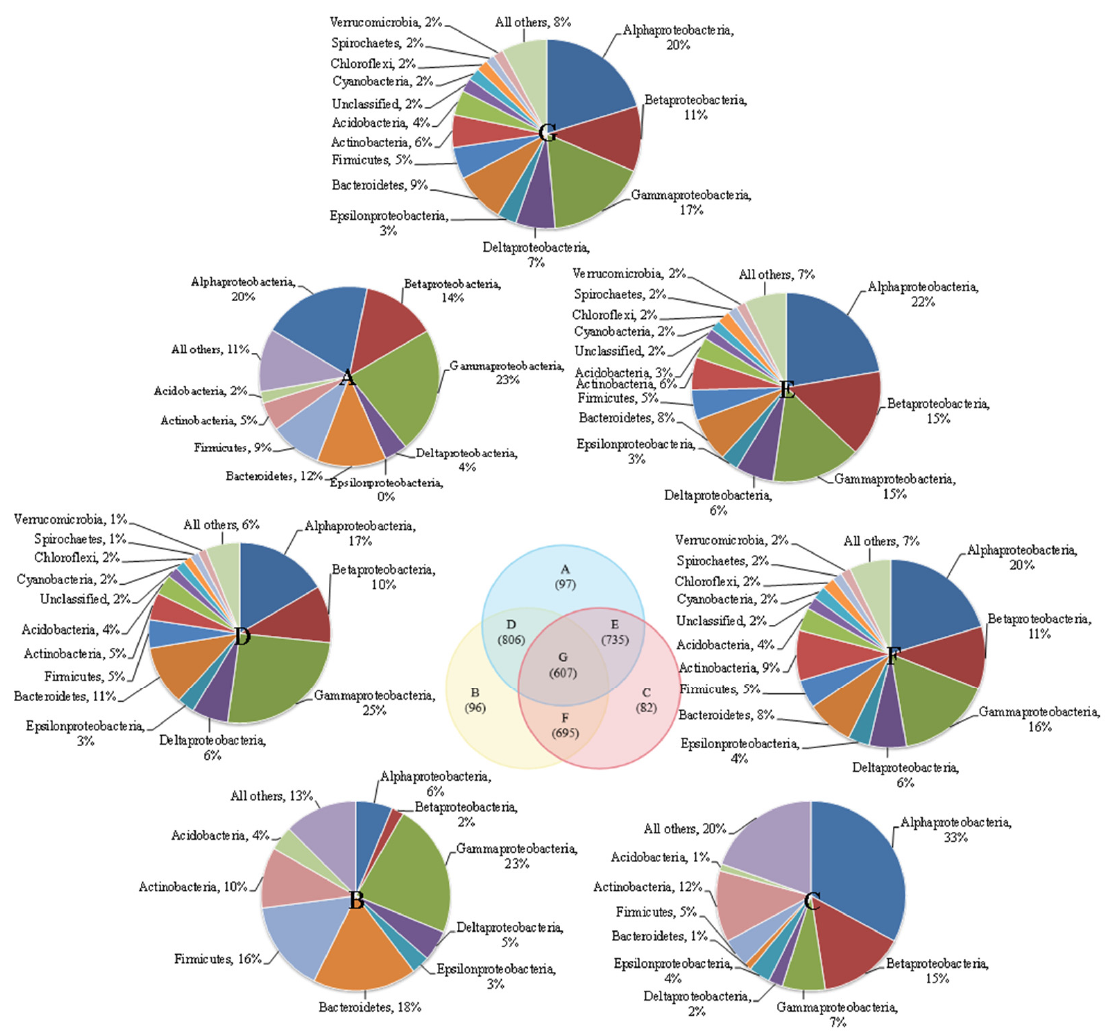
Figure 1. Venn diagram of three MBRs communities overlapped.